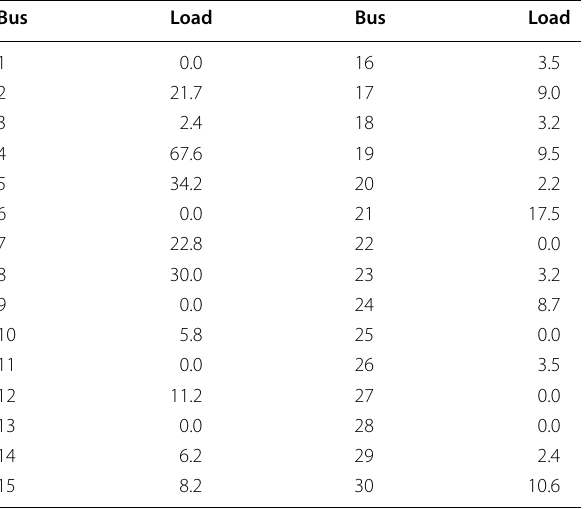
Table 12 Bus load and injection data of IEEE 30-bus system Table 13 Reactive power limit of IEEE-30 bus test